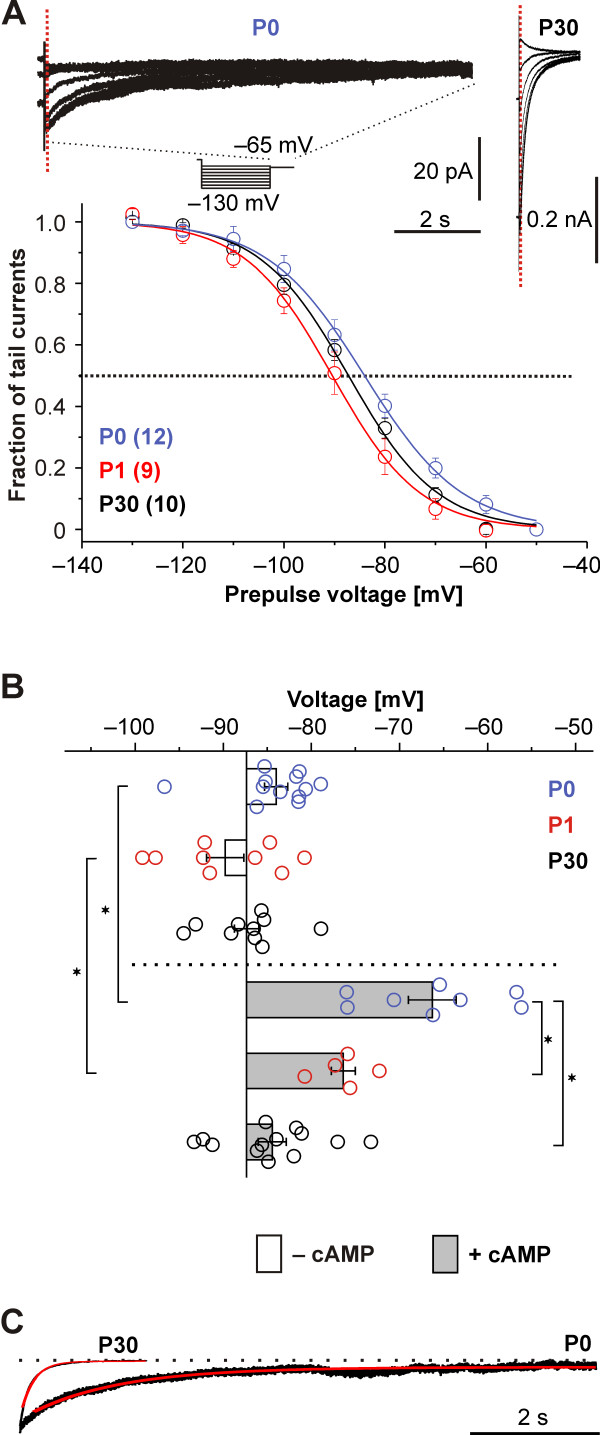
Ihvoltage dependence and its modulation by cAMP. (A)Top: Family of tail currents from neocortical neurons at P0 (left) and at P30 (right). For both examples, different durations of the tail currents are displayed on return to −65 mV from preceding 2-second voltage steps between −130 and −60 mV (see voltage protocol). Tail current amplitudes were measured after the cessation of capacitive transients (dotted vertical line). The time scale is representative for both ages. Bottom: Population data of steady-state activation curves without intracellular cAMP, depicted as mean relative tail currents, plotted against the preceding test potential. For illustration purposes the means were fitted using a Boltzmann function, although during analyses each single neuron was fitted. For individual experimental values compare (B). (B) Population data on the modulation of the half-maximal activation voltage (V1/2) by cAMP at P0, P1 and P30. The V1/2 did not differ between ages when cAMP was absent from the intracellular solution (open bars). Adding 100 μM cAMP intracellularly shifted the V1/2 at P0 and P1 to more depolarized voltages, but did not change the V1/2 at P30 (lower part, grey bars). (C) Age dependence of the current deactivation at −120 mV for a P0 and a P30 neuron in a scaled example. The current was fitted by a single exponential equation (red) and showed a prolonged deactivation at P0. *Indicates significance P < 0.05 (ANOVA with Tukey post-hoc test).